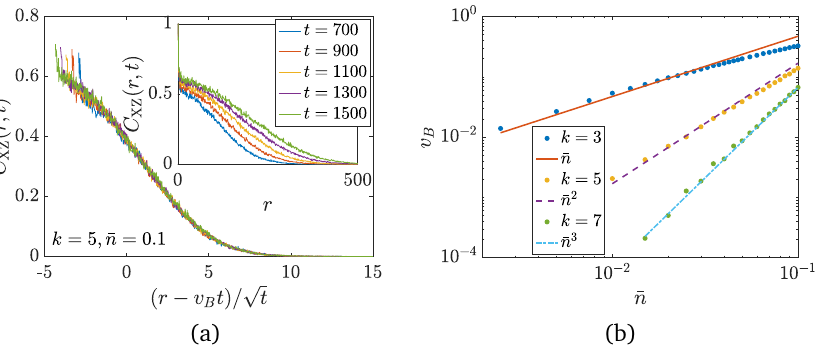
( r , t ) with k = 5 and L = 1000. XZ as a function of n for different k . Different B